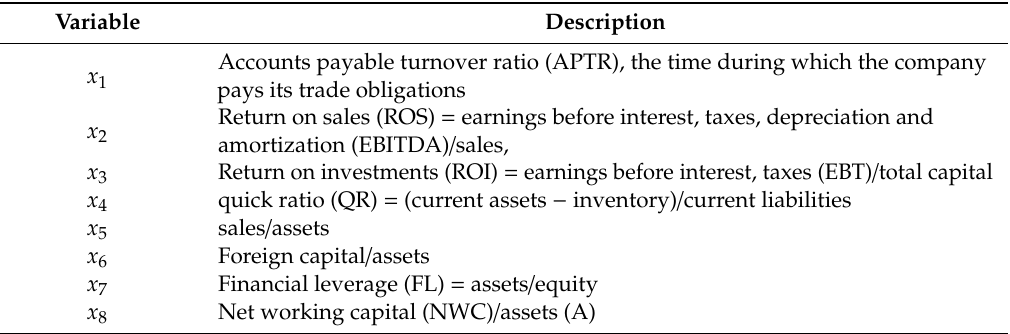
Table 1. Variables entering the analysis.